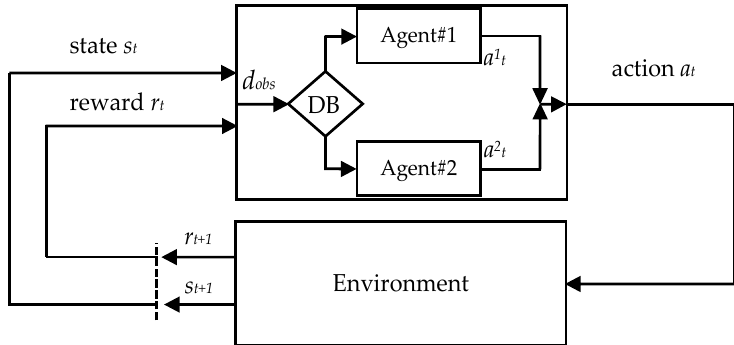
Figure 4. Multi-agent system.